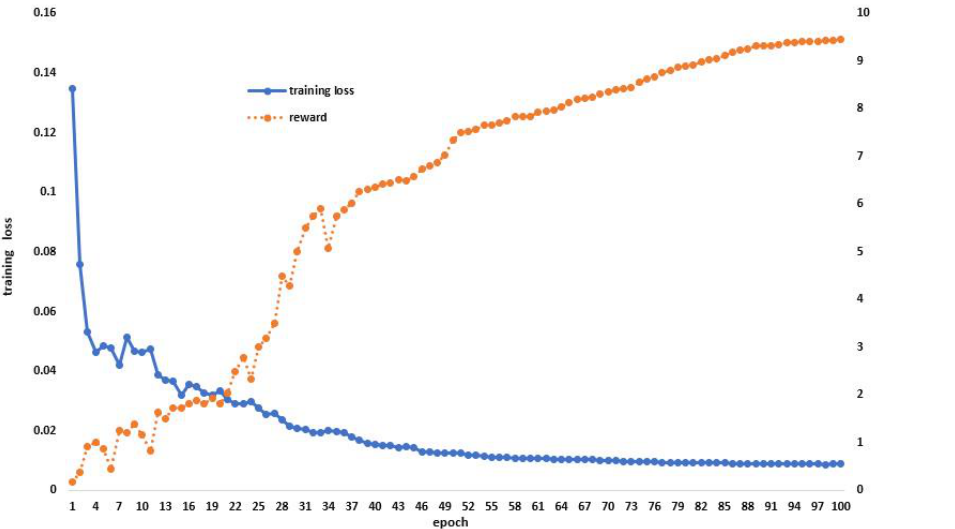
Figure 4. Model training situation, use the loss function to optimize the gradient during model training and display the score of the excitation function in the